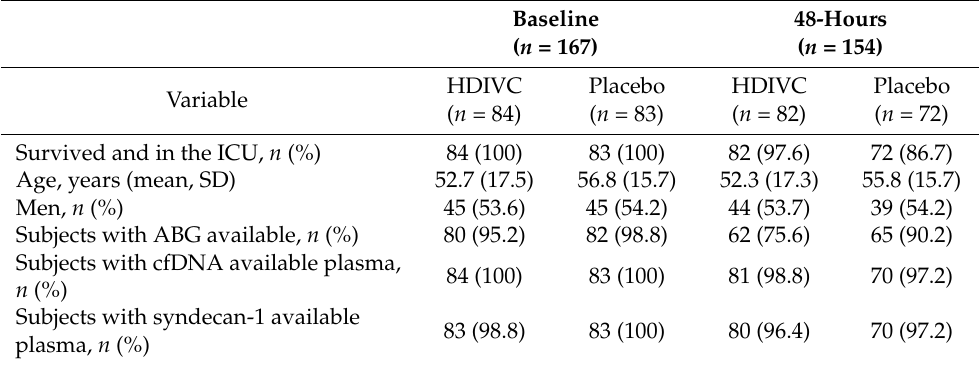
Table 1. Patient characteristics and specimen numbers from the randomized controlled